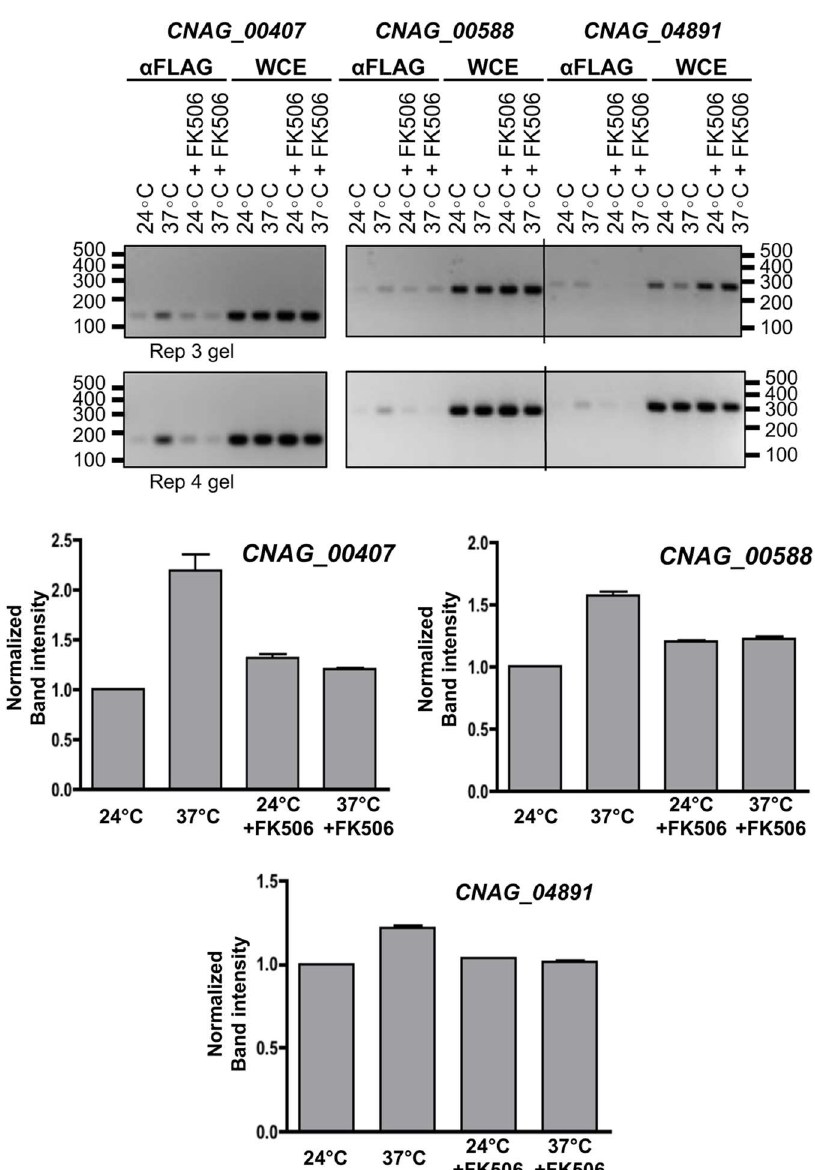
Fig 6. Crz1 binding of promoter regions increasesunder thermal stress. Cultures of the Crz1-4xFLAG strain were grown to exponentialphaseat 24˚C, shifted to 37˚C with and without FK506 for 30 min, and crosslinked with formaldehyde. Whole cell lysates (WCE) were preparedand ChIP-PCRwas performed employinganti-FLAG nickel beads and specific DNA primers for three genes(CNAG_00588, CNAG_00407, and CNAG_04861) as describedin materialand methods. PCR DNA products for the DNA obtained from the anti-FLAG CHIP-PCR or from WCE-PCR were fractionated in agarosegels. Primers for each gene tested were designedto producea product 150–280bp long. Quantificationof band intensity was analyzedusing ImageJ, and values were normalized to the 24˚C control. Results shown are representative of two biological replicates (labelledas Rep 3 gel and Rep 4 gel